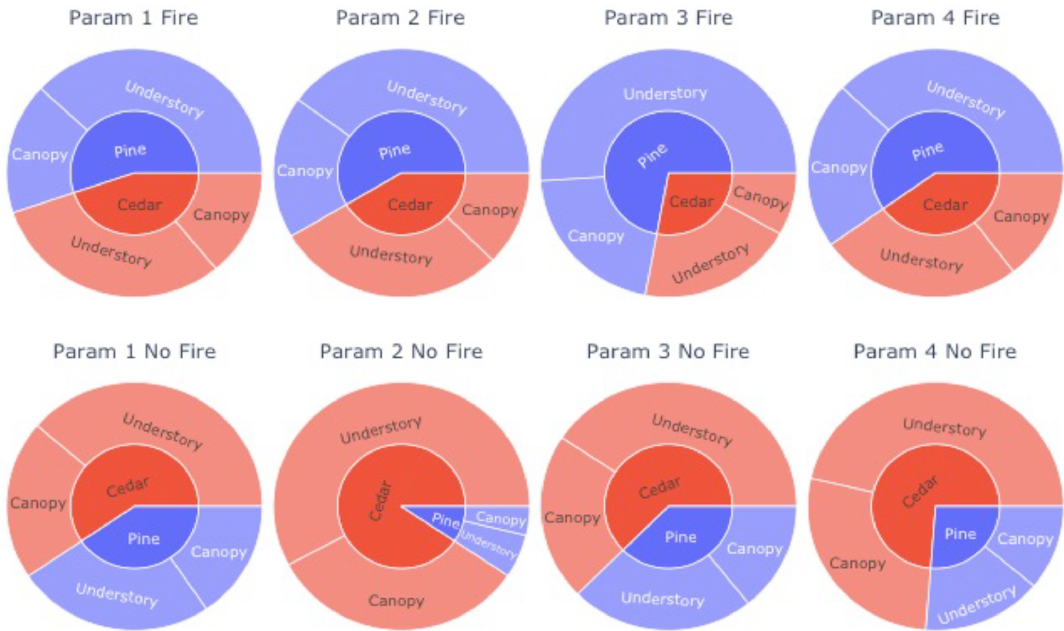
Figure 4. Fraction of pine (blue) and incense cedar (red) basal area (inner circle), differentiated by canopy position (outer circle), in simula- tions at the Soaproot Saddle flux tower site. Each circle shows one of the four parameterizations retained after filtering based on expectations in Table 1. Simulations were started from even stands and run with fire active (top row) and inactive (bottom row) for 100 years with recycled 1979–2015 climate.